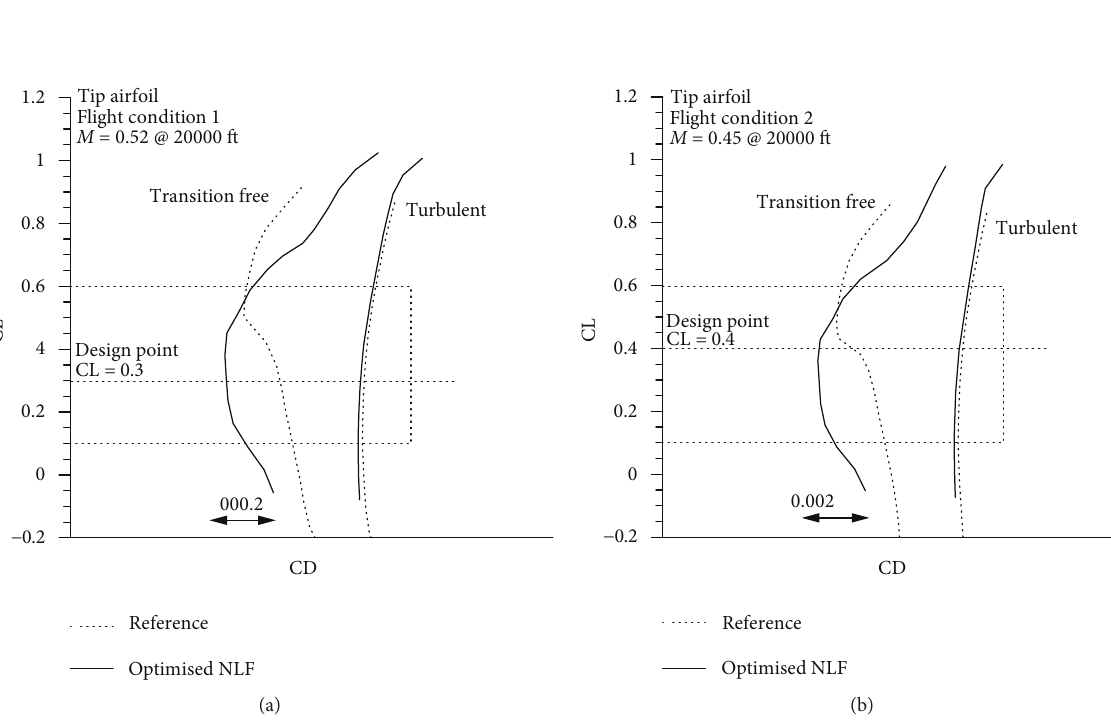
Figure 6: Computed 2D performance of optimized root airfoil.